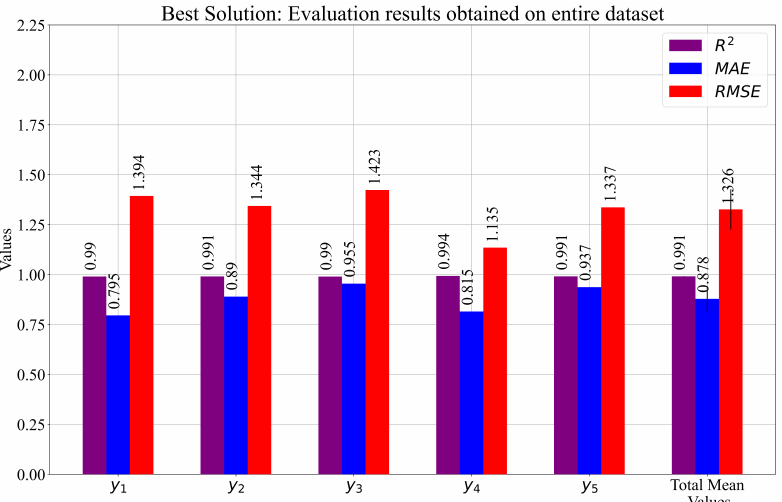
Figure 8. The graphical representation of the performance metric values obtained with the best combination of SEs on the entire dataset. σ is shown in the case of the total mean values in the form of an error